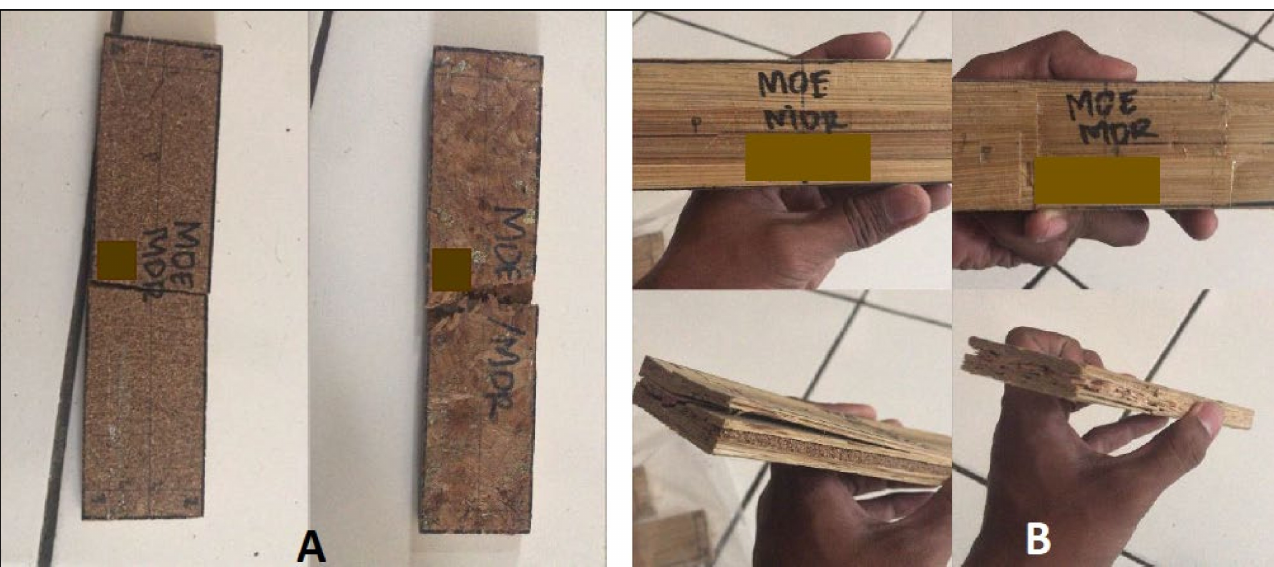
Figure 15. The appearance of damage in samples in MOE and MOR testing: nonstrand-coated board ( A ), and strand-coated board ( B